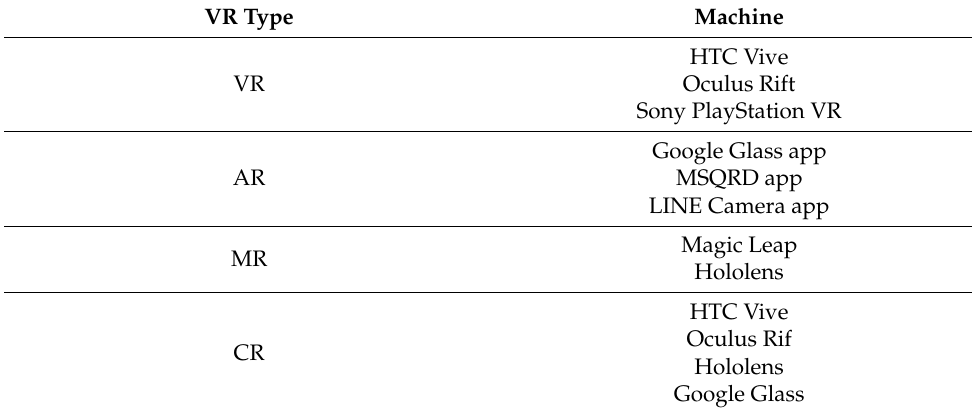
Figure 2. Different kind of VR game. Table 1. Main machine brand in VR game.